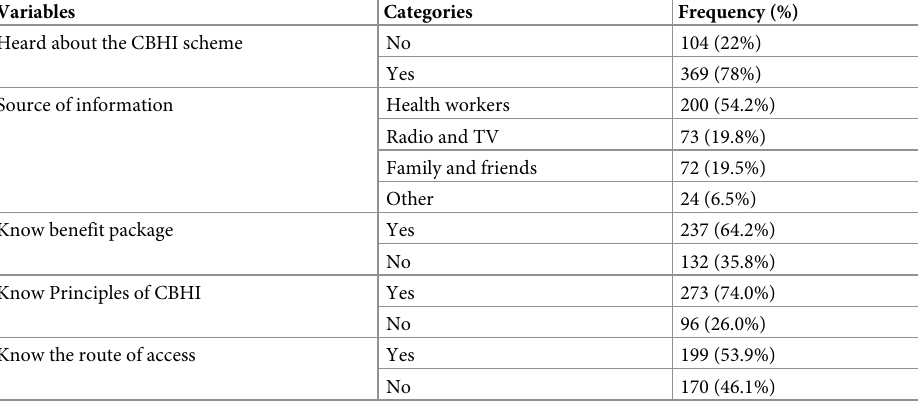
Table 3. Respondents’ knowledge of a community-based health insurance